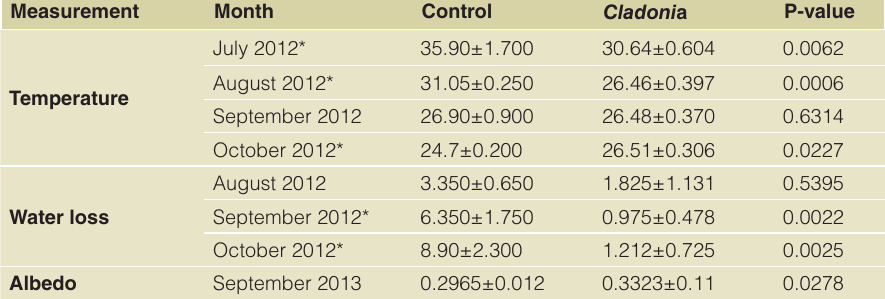
Figure 2. A Cladonia module used in the lichen trial. Each module had a length and width of 36cm with a substrate depth of Table 1. Mean (± SE) temperature ( ° C), water loss (reduction in % VMC) and albedo (reflected radiation/incoming radiation) of the Cladonia modules compared to the substrate-only controls. An (*) indicates a significant difference (>0.05) between the substrate-only control and Cladonia treatment determined by a t-test.